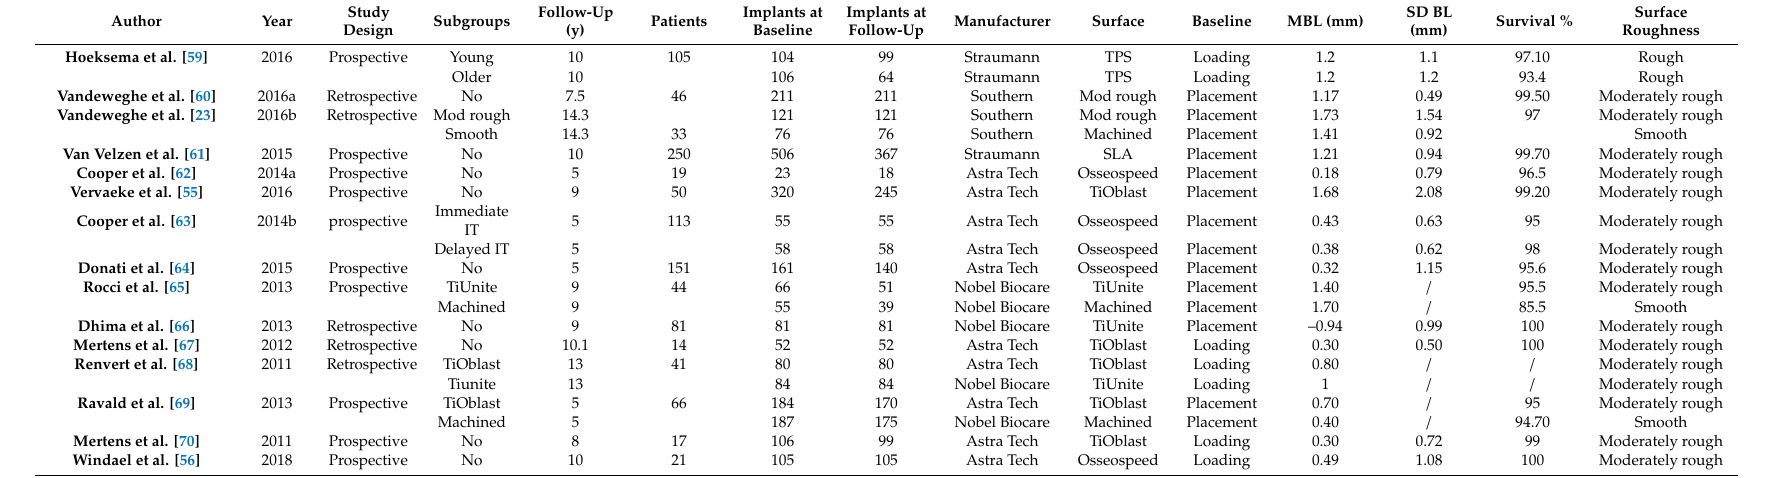
Table 7. Overview of long-term clinical studies concerning mostly moderate rough implant